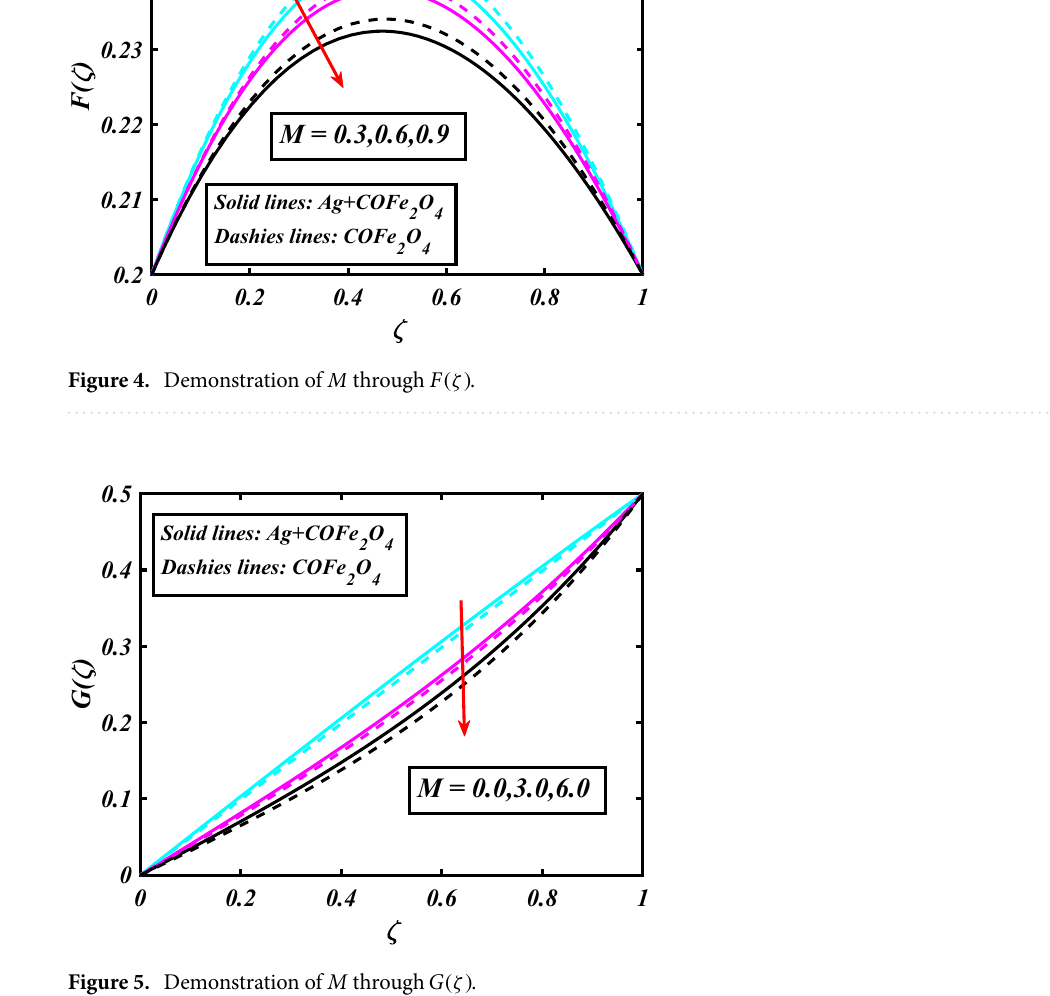
Figure 5. Demonstration of M through G (ζ)